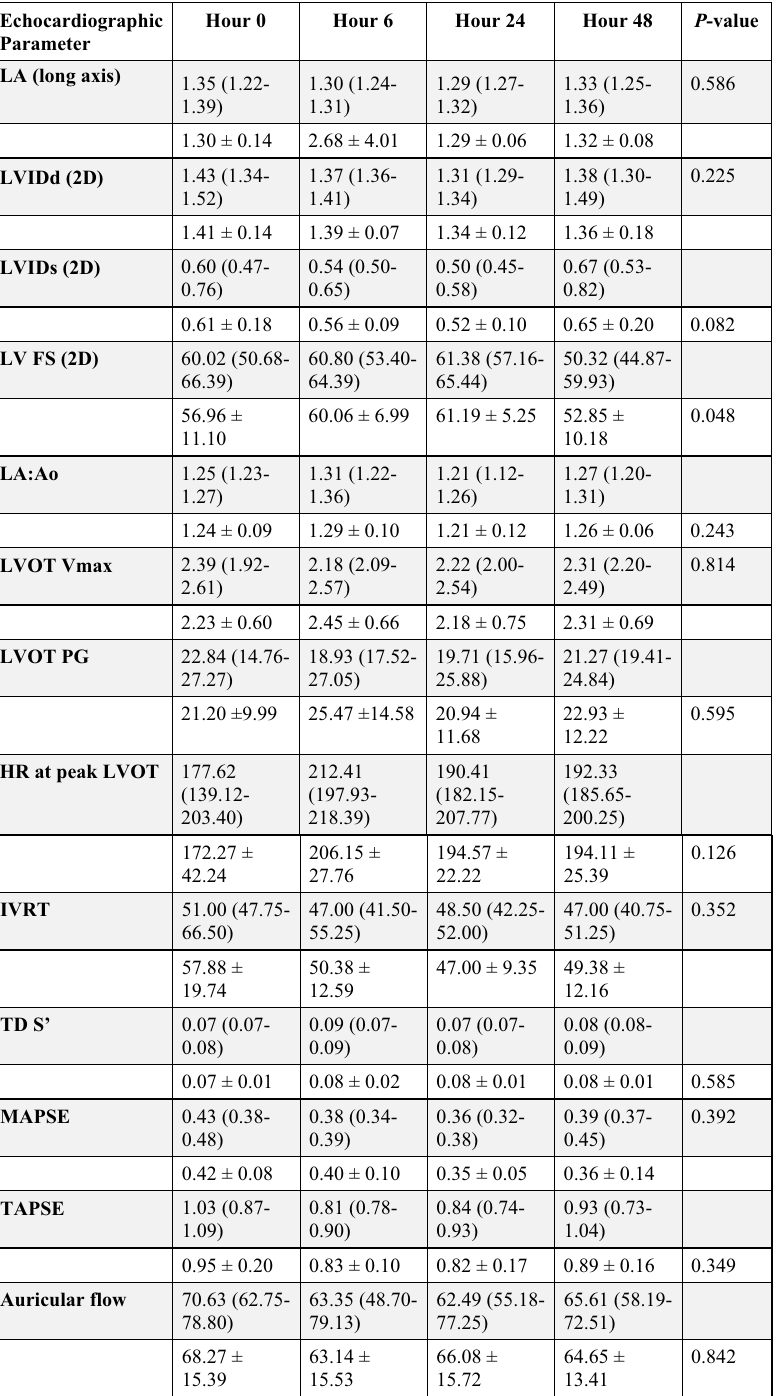
Table 2. Treatment group A: Vehicle. Echocardiographic variables for the vehicle treatment group with reported mean ± standard deviation (unshaded rows) and median and interquartile range (shaded rows). The P value for variables that were statistically evaluated by either repeated measures one-way ANOVA or Friedman’s test are shown. LA left atrium, LVIDd left ventricular internal dimensions (diastole), LVIDs left ventricular internal dimensions (systole), LV left ventricle, FS fractional shortening, LVIDd left ventricular internal diameter (diastole), LVIDs left ventricular internal diameter (systole), LA/Ao left atrial-to-aortic root ratio, LVOT left ventricular outflow tract, Vmax velocity (maximum), PG pressure gradient, HR heart rate, IVRT isovolumic relaxation time, TD tissue Doppler, S’ mitral annular systolic velocity, MAPSE mitral annular plane systolic excursion, TAPSE tricuspid annular plane systolic